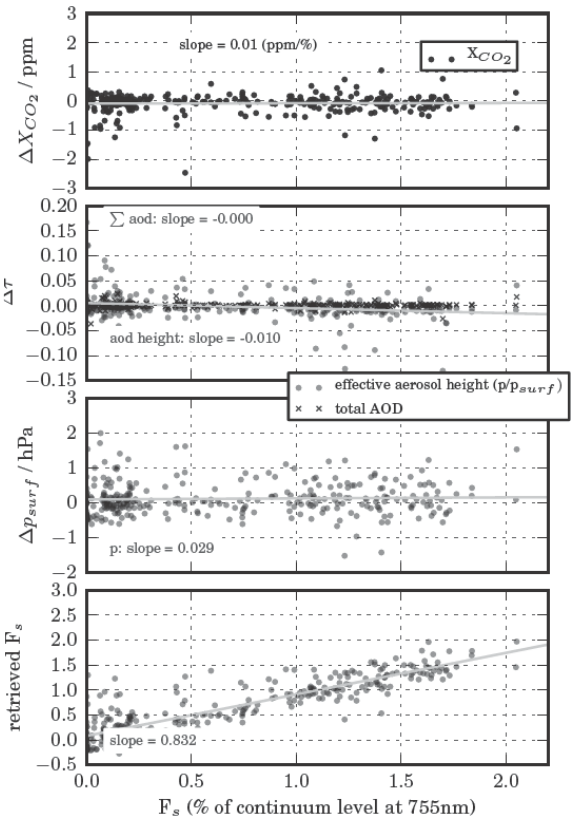
Fig. 7. Case #2b: Changes in retrieved X CO induced by chlorophyll fluorescence if fluorescence is fitted. Apart from the fluorescence fit, identical to case #2a, Fig. 4.